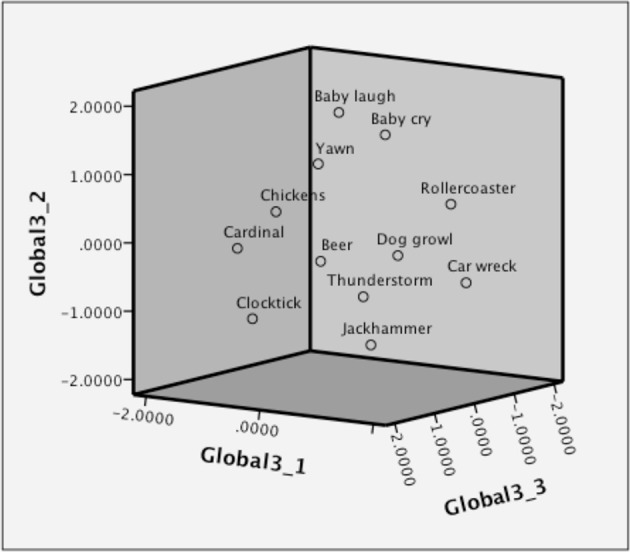
3-Dimensional MDS solution for global dissimilarity.